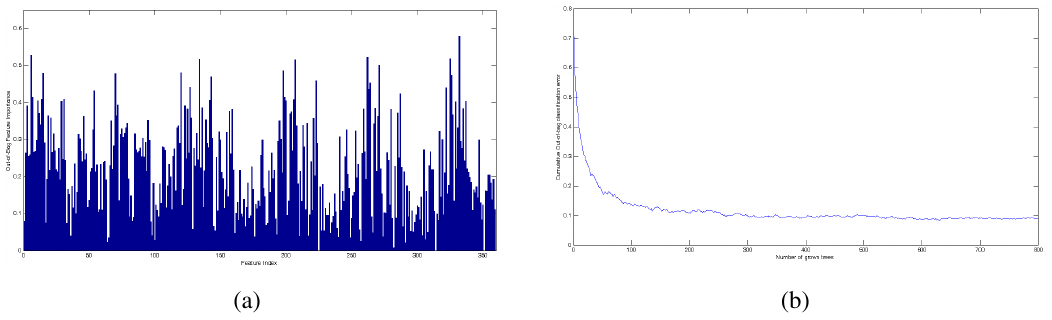
Figure 11. ( a ) Importance variables computed by the RF algorithm; ( b ) out-of-bag error in the training phase. Classification performance by using RF-based feature selection and the NN-based